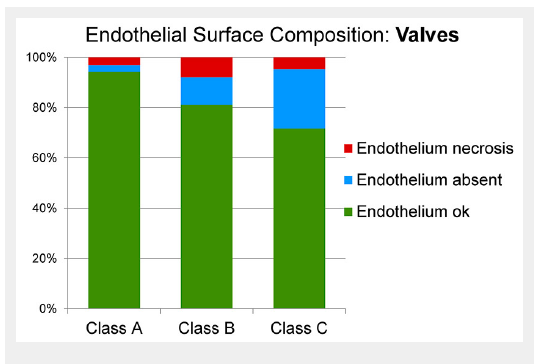
Surface analysis of the endothelium of the valve in the three classes of venous disease (A: minimal; B: early stage; C: advanced).